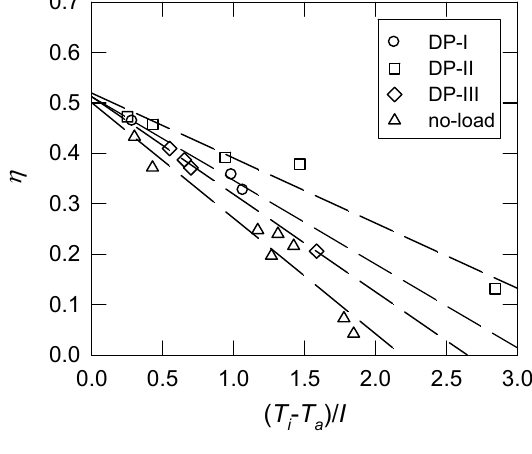
Figure 5. Thermal efficiency, no-load and intermittent load